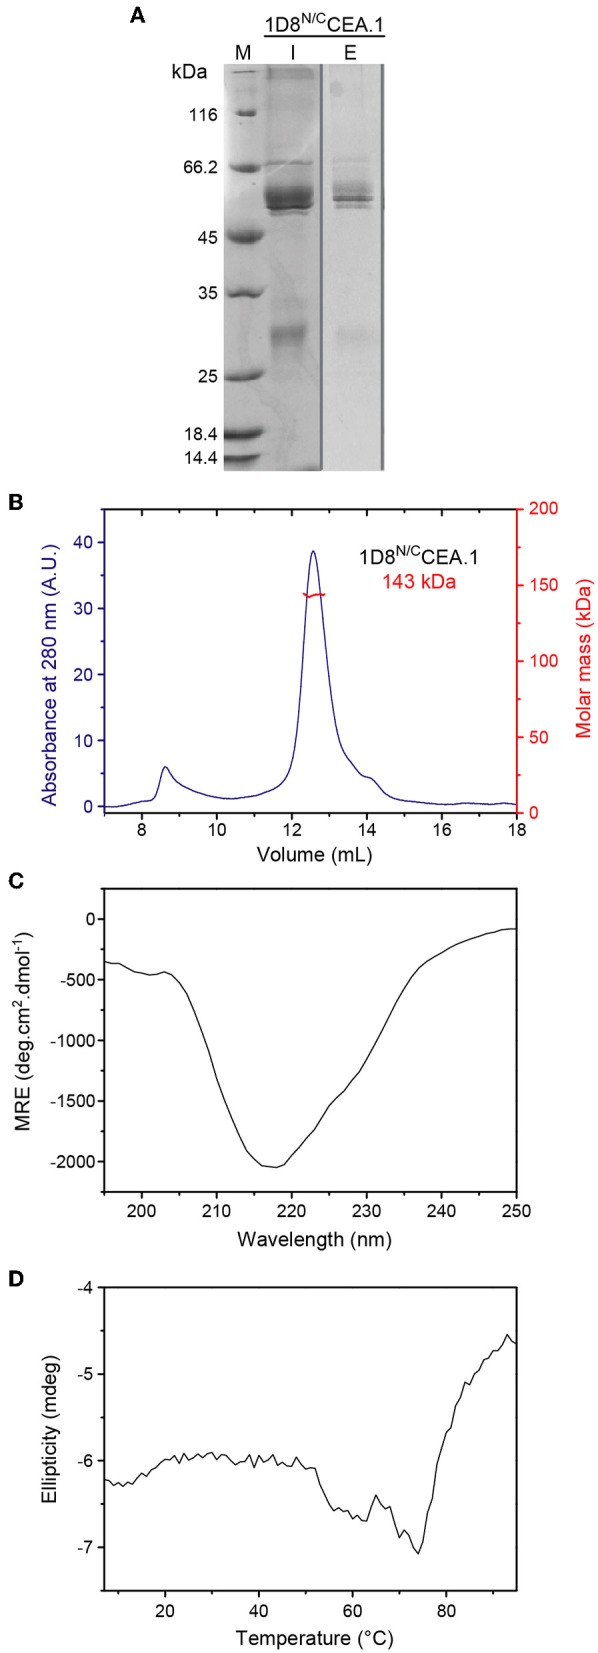
Structural characterization of purified 1D8N/CCEA.1 trimerbody. (A) Reducing SDS-PAGE of 1D8N/CCEA.1. The sample injected in the SEC column (I, 5 μL of the 0.3 g/L stock) and eluted at 12.6 mL (E; total protein present in the central 300 μL fraction was precipitated before loading). The gray vertical line indicates that the lanes belong to different gels. (B) Oligomeric analysis of the purified 1D8N/CCEA.1 trimerbody by SEC-MALS with the indicated molecular mass measured at the center of the chromatography peak. (C) Circular dichroism spectrum (mean residue ellipticity) of 1D8N/CCEA.1, and (D) thermal denaturation measured by the change in ellipticity at 218 nm.